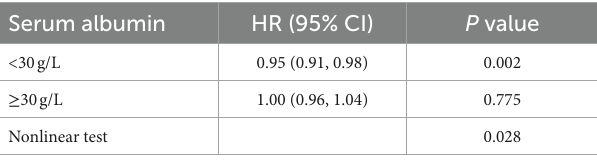
TABLE 3 Nonlinear relationship between serum albumin and in-hospital mortality. Serum